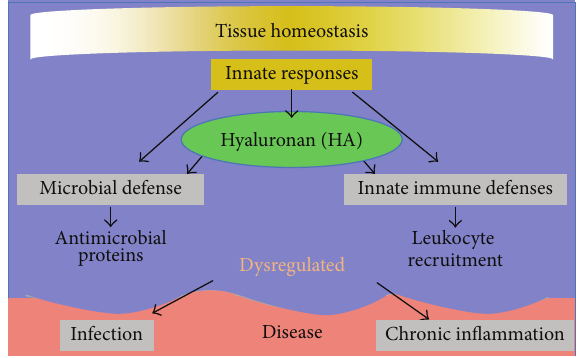
Figure 2: HA plays roles in normal intestinal tissue homeostasis and functions in innate immune and antimicrobial responses. Dysregulation of HA-mediated responses may contribute to chronic inflammation or insufficient protection against intestinal